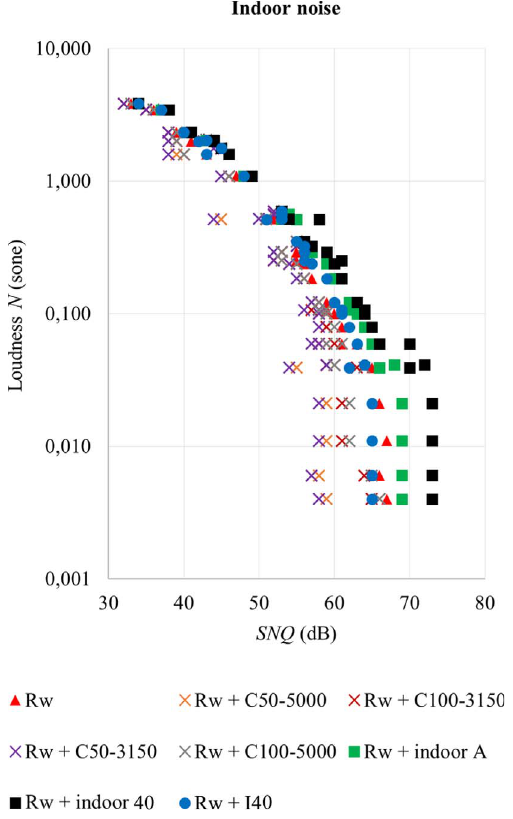
Figure 5. Correlation between the Zwicker ’ s Loudness values of transmitted sounds (in case of indoor noise at the emitting side) and values of 8 SNQs for the tested walls.